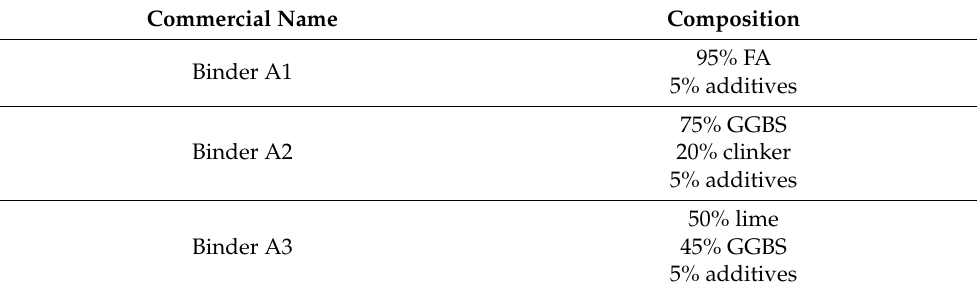
Table 1. Composition of ecobinders used in the study.